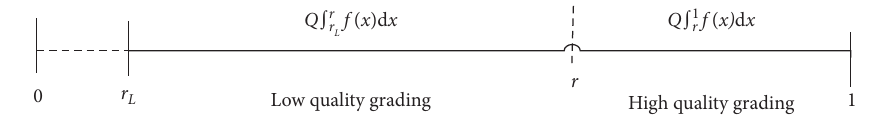
Figure 1: The quality grading model of fresh food. Table 1: Notations